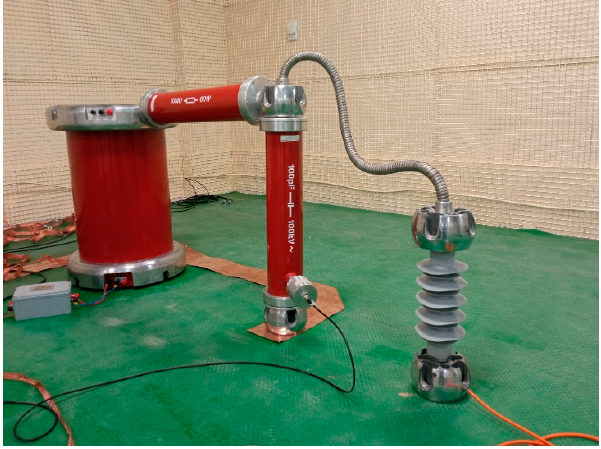
Figure 5. The experimental setup for the leakage-current measurement in a laboratory .